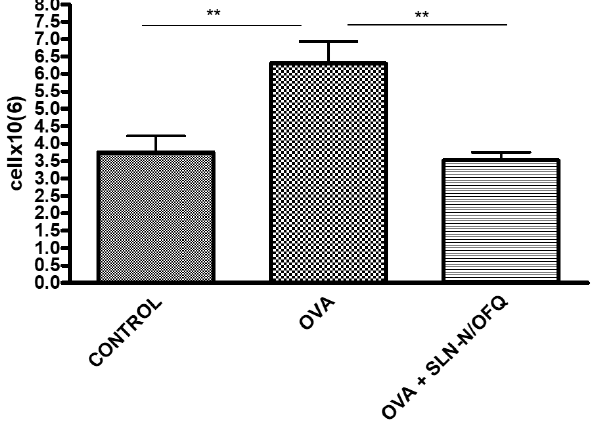
Figure 6. Effect of N/OFQ-SLNs on inflammatory cells. In the bronchoalveolar lavage (BAL) fluid, samples treatment with N/OFQ-SLNs significantly reduces the total number of inflammatory cells compared to the control group. Data are means ± SEM (n = 10). ** p < 0.01.